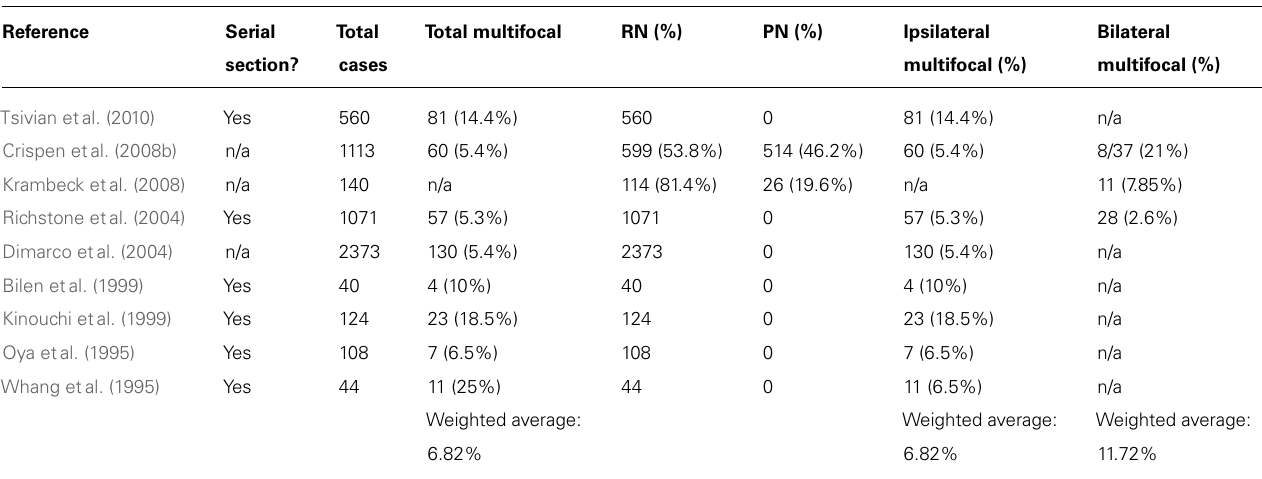
Weighted average: